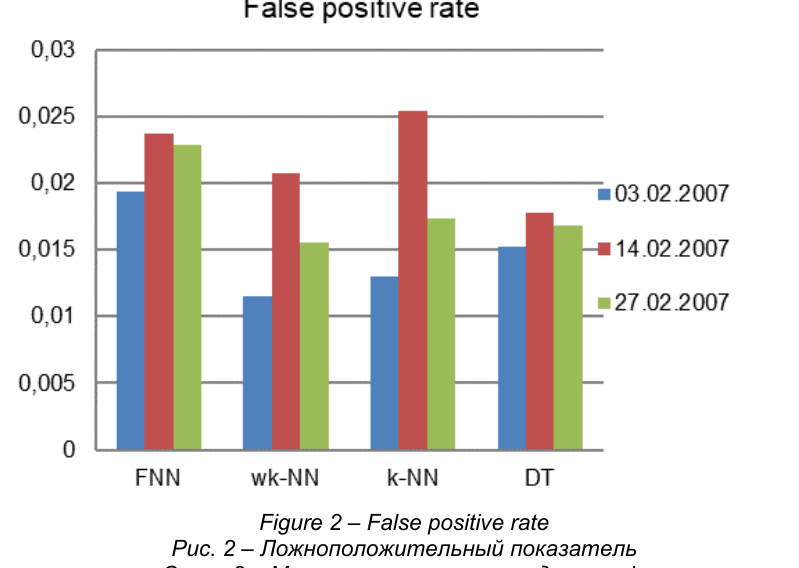
Figure 2 – False positive rate Рис . 2 – Ложноположительный показатель